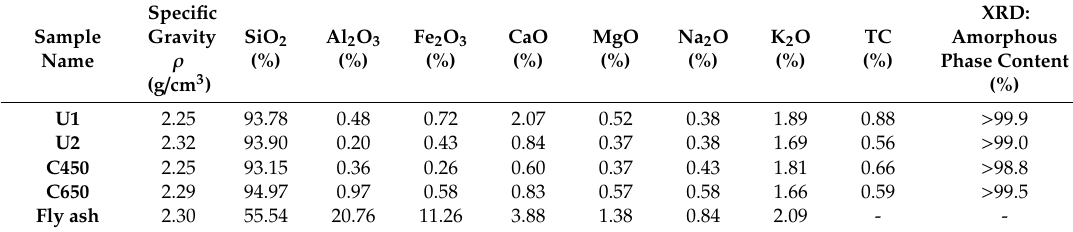
Table 3. Physical and chemical material properties.